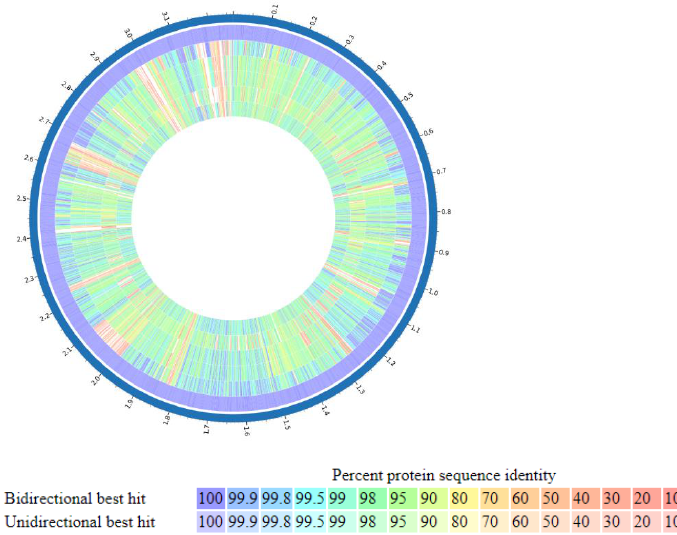
Figure 4. Proteome comparison: The entire proteome for each different strain is aligned against the P. bifermentans GBRC proteome. Track order from outside to inside is shown in the top right part of the figure where the reference strain, GBRC, is the most outside circle. The color key indicates the percentage of protein sequence similarity over the entire genome. The list of tracks, from outside to inside includes P. bifermentans GBRC, P. bifermentans strain Cbm, P. bifermentans strain MHMC-14, P. bifermentans strain DSM 14991 , P. benzoelyticum strain JC302 , and P. bifermentans subsp. murico- litidis 123.